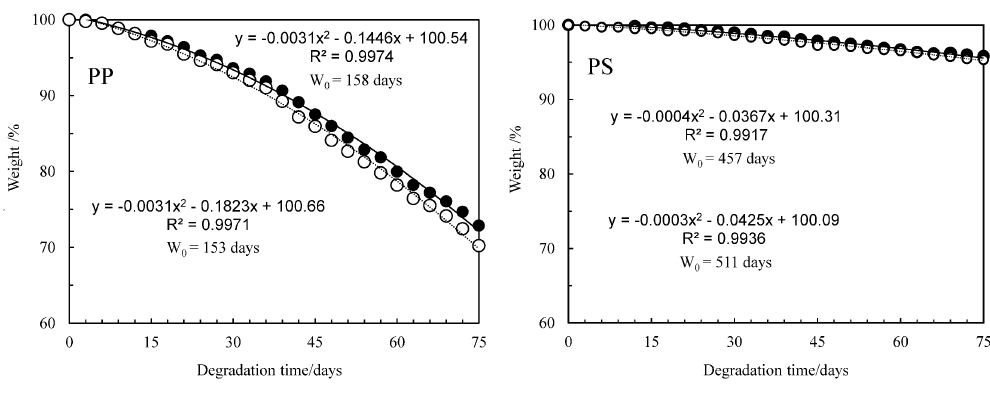
Figure 5. PP and PS weight ratio vs degradation